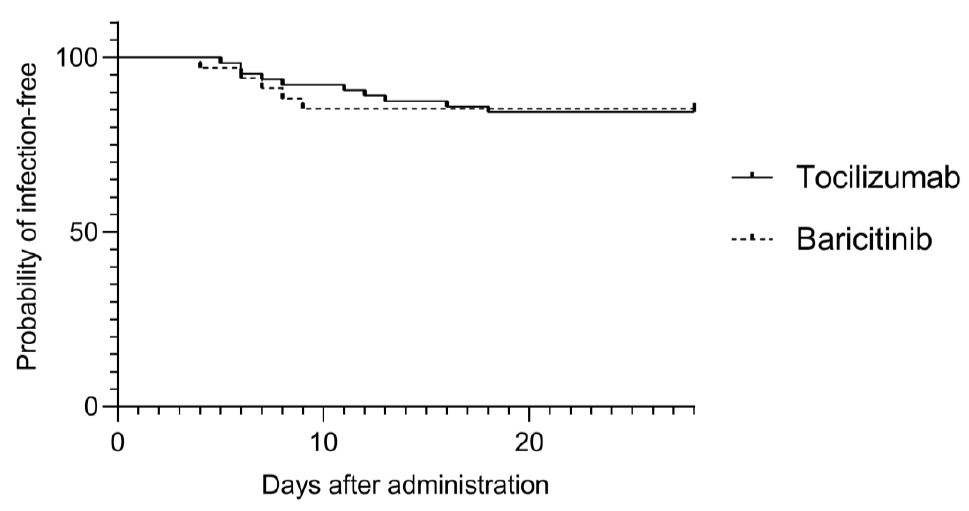
Figure 2. Kaplan–Meier estimates of secondary infection free survival between tocilizumab and Figure 2. Kaplan – Meier estimates of secondary infection free survival between tocilizumab and bar- baricitinib icitinib groups.